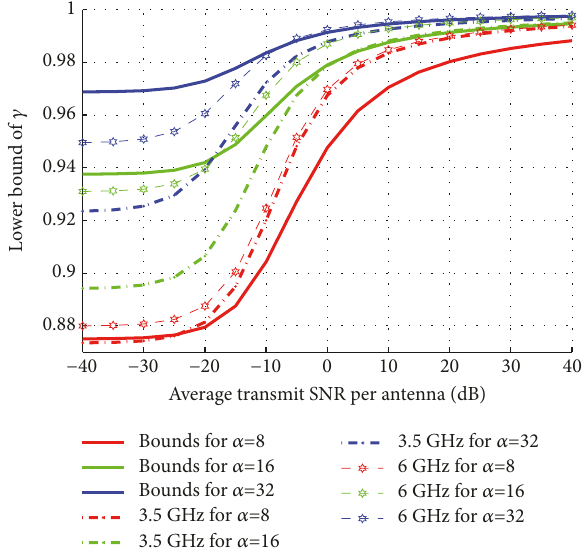
Figure 8: 3.5 GHz and 6 GHz measurementresults of 𝛾 with respect to the average transmit SNR for different DoF of the